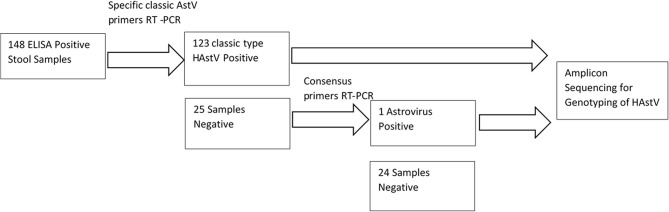
Schematic diagram of RT-PCR screening of astrovirus for sequencing.